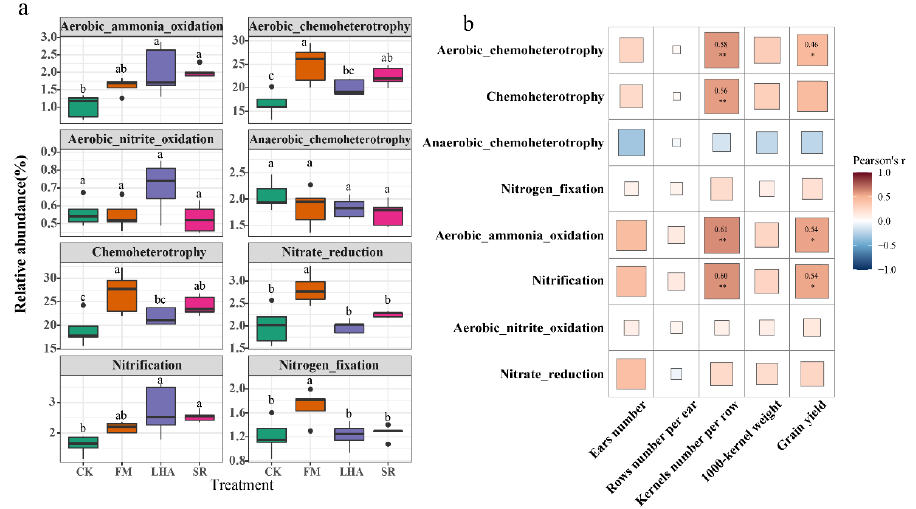
Figure 6. Functional prediction of bacterial groups in the different treatments using FAPROTAX. Different letters indicate significant differences between the different treatments at the p < 0.05 level ( a ); Pearson correlation analysis of the functionally predicted abundance of bacterial communities with yield and yield components ( b ). The labels indicate significant levels tested by Pearson correlation (* p < 0.05, ** p < 0.01).